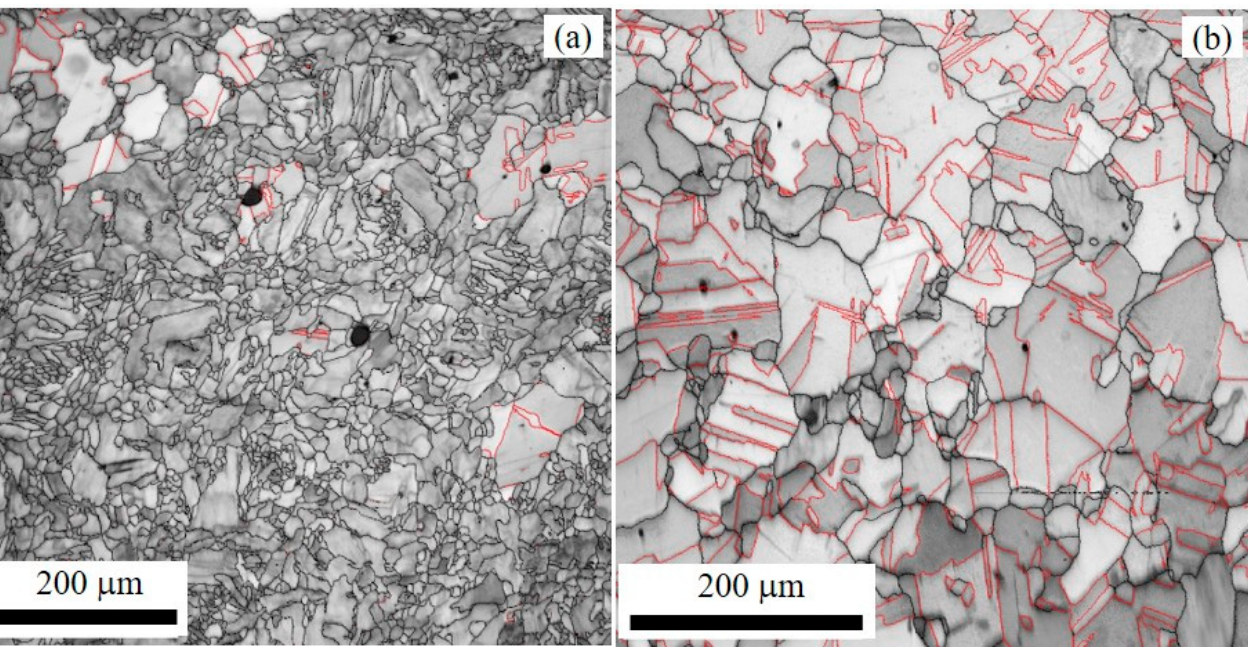
Figure 4. EBSD ‐ IQ maps showing grain boundaries (black lines) and twin boundaries (red lines): ( a ) STA1100 ‐ 1 h (STA1), ( b ) STA1100 ‐ 3 h (STA3).